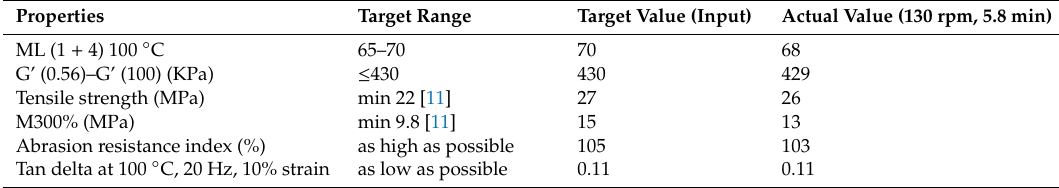
Figure 14. Overlay plot of all properties. Table 5. Target values vs. actual values of the desired properties .